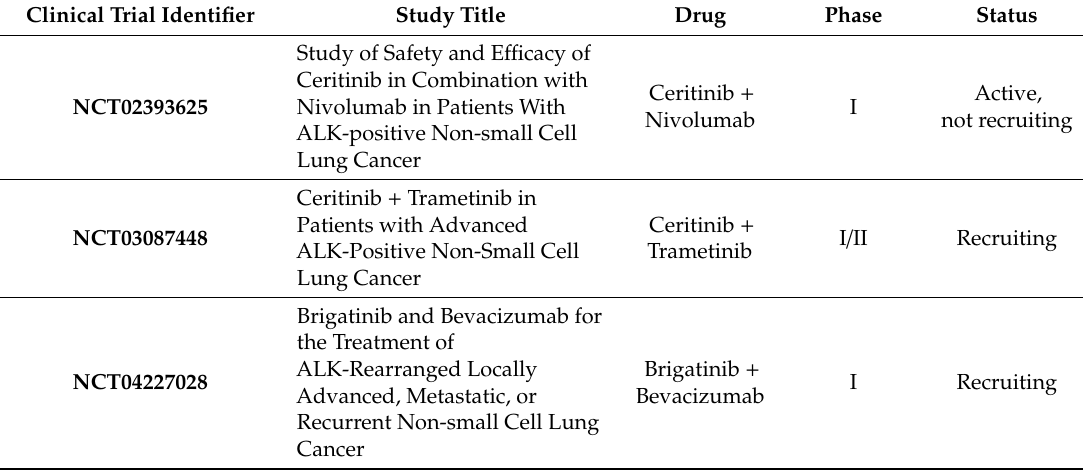
Summary of ongoing trials with combination therapy in ALK-rearranged NSCLCs (source: